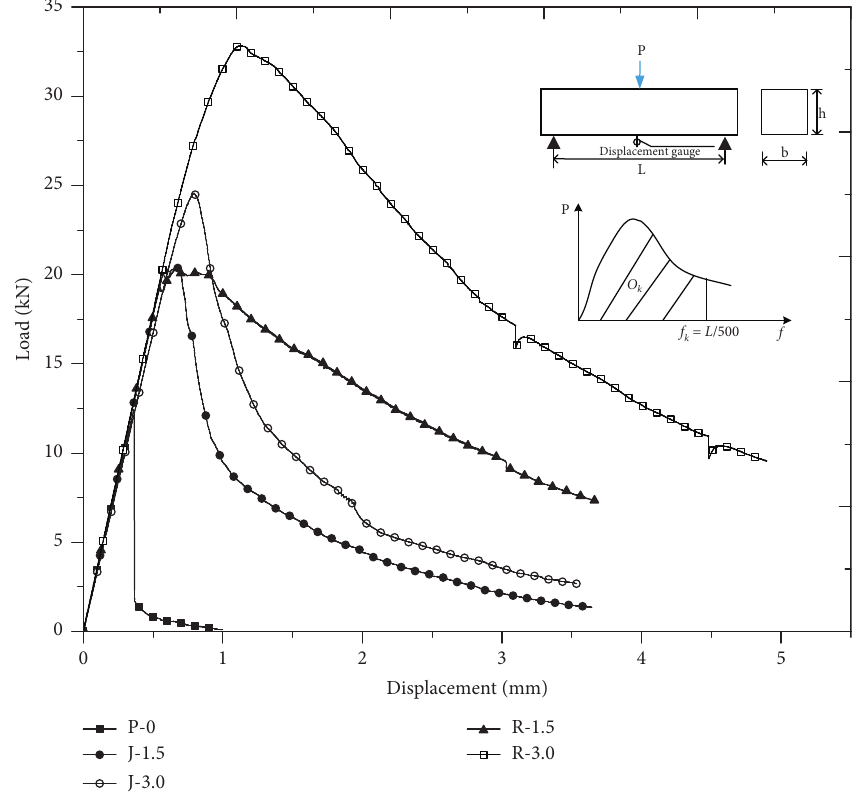
Figure 9: Plot of load-displacement curves. Table 6: Properties of hardened